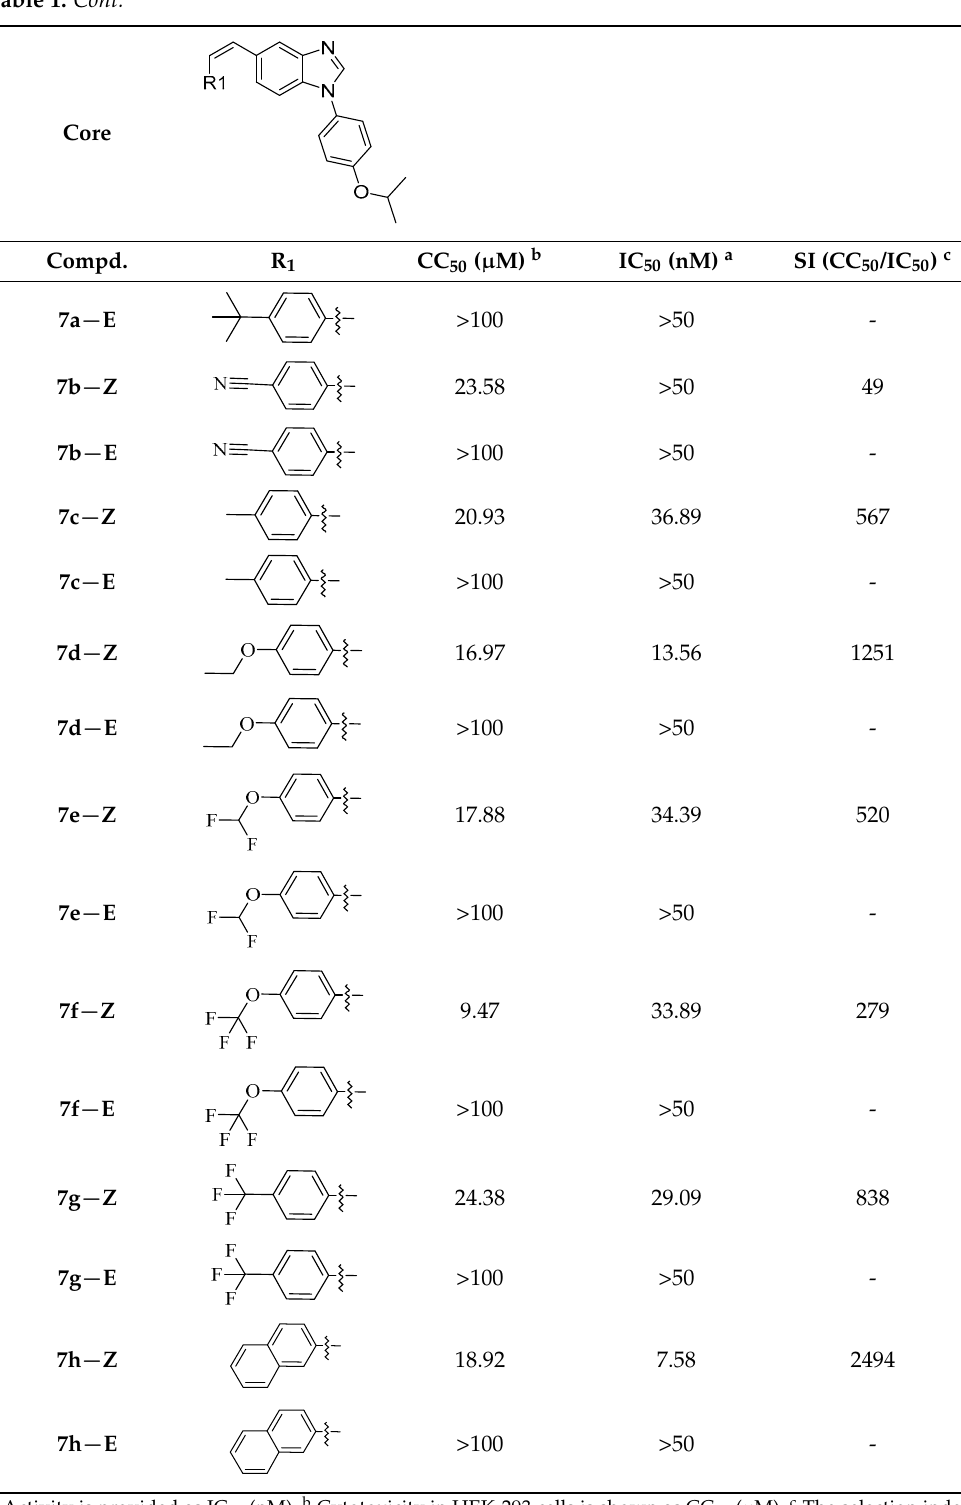
Table 1. Inhibition of LASVpv pseudotyped viruses by synthetic compounds 7a − 7h(Z/E) . Figure 3. Concentration–response curves of representative compounds 7d − Z , 7h − Z , 13c , 13d , 13f, and LHF − 535 to LASVpv. Table 1. Cont.